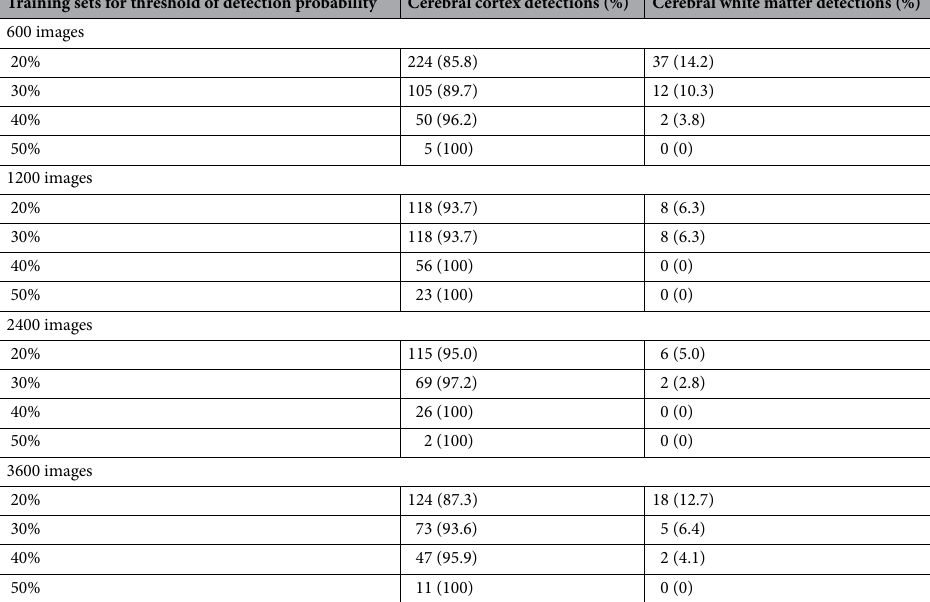
Table 2. Location of false-positive detections by the threshold of detection probability for each training set of composite images.